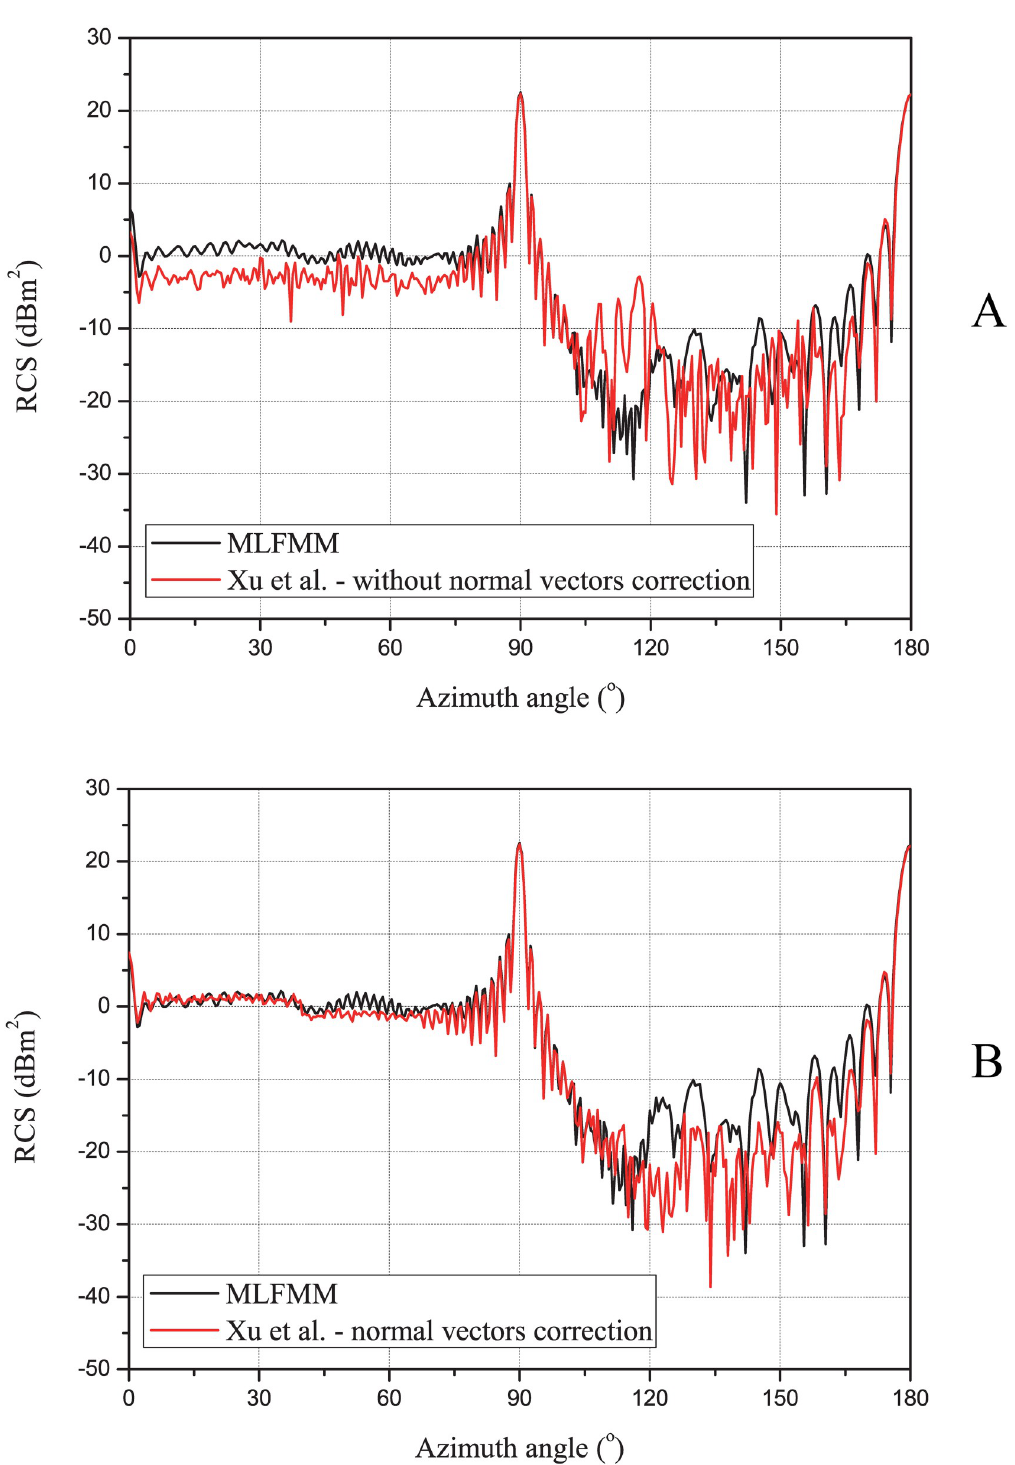
Fig 7. The RCS results of our method and MLFMM algorithm. (Panel A), our method without normal vectors correction. (Panel B) our method with normal vectors correction.